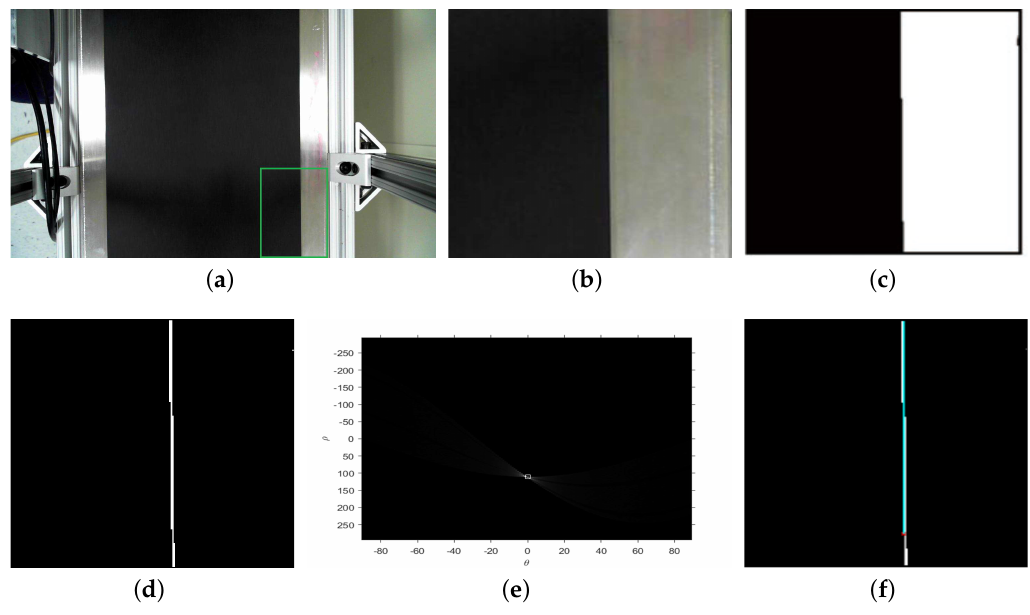
Figure 5. Image processing results using Method 1: ( a ) original image, ( b ) region of interest, ( c ) binary image, ( d ) result of Canny algorithm, ( e ) line in the parameter space, ( f ) result of Hough transform.